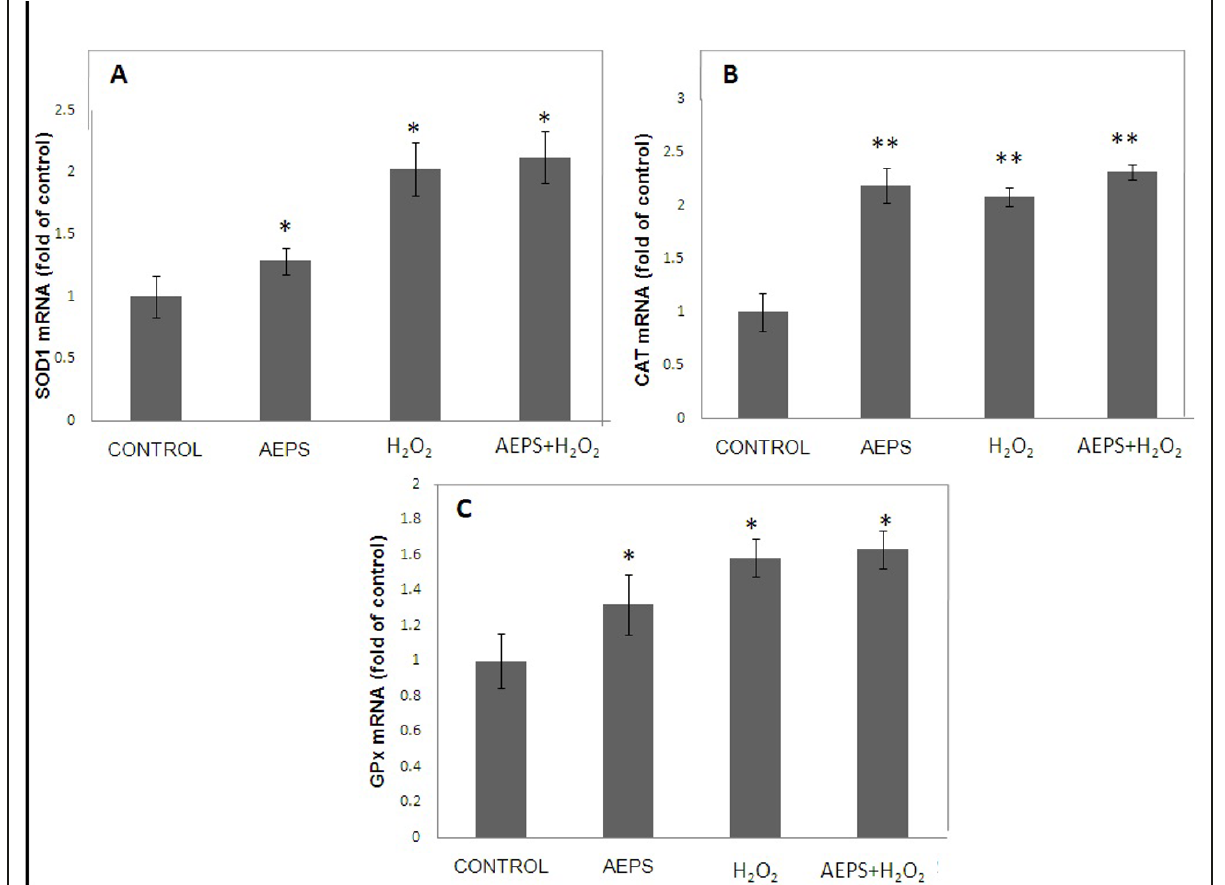
Figure 5 SOD1, CAT and GPx mRNA expression in HUVECs . Figure 5 represents the bar chart showing SOD1 (A), CAT (B) and GPx (C) mRNA expression in control, AEPS, H 2 O 2 and AEPS + H 2 O 2 groups. Single treatment of HUVEC with AEPS or H 2 O 2 significantly increased SOD1, CAT and GPx mRNA expression. The highest level of SOD1, CAT and GPx mRNA expression was observed in HUVEC treated with both AEPS and H 2 O 2 . Data are expressed as mean ± SEM of n = 10. (*) p < 0.05 vs. control; (**) p < 0.01 vs.